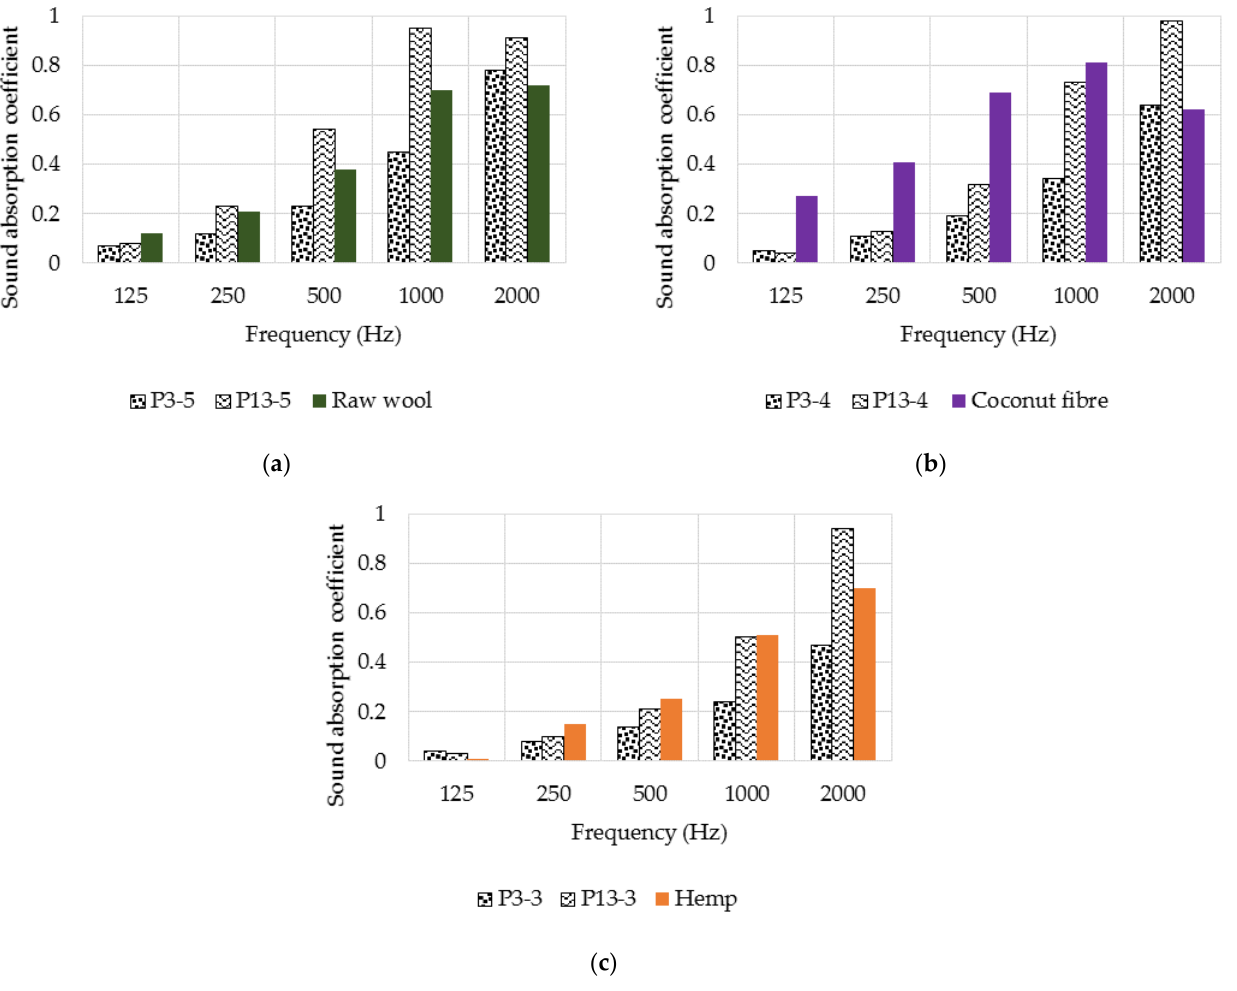
Figure 23. Sound absorption coefficients as a function of frequency for materials with different thicknesses: ( a ) 50 mm; ( b ) 40 mm; ( c ) 30 mm (data from Refs. [56–58]).